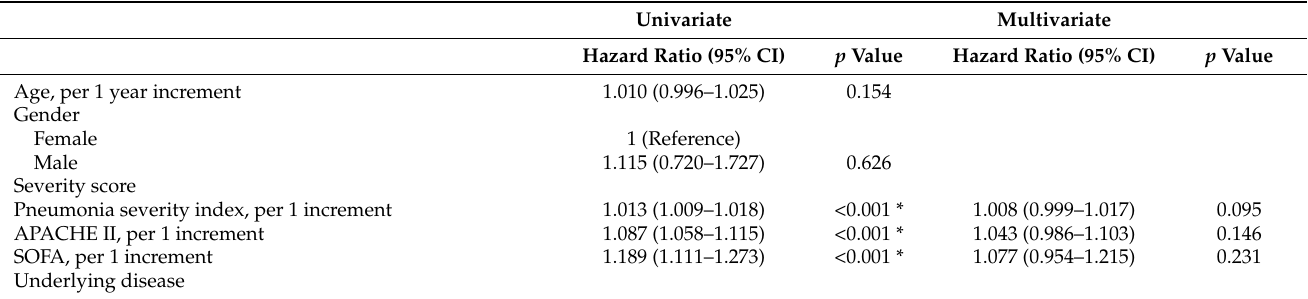
Table 4. Predictive factors for 60 days mortality in all